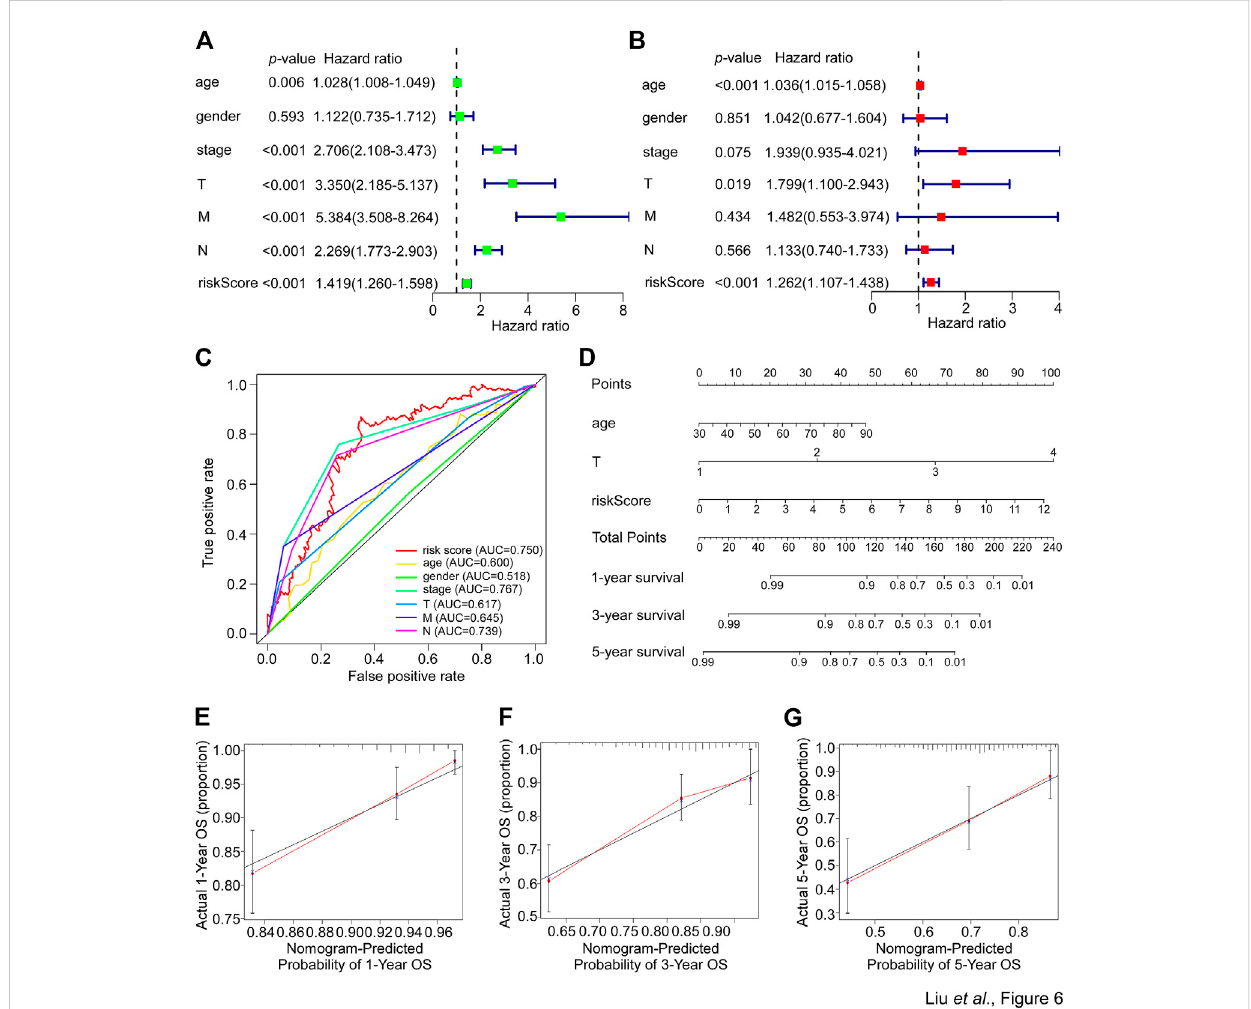
FIGURE 6 Nomogram developmentin the TCGA cohort. (A) The clinical factors and risk score calculated by the risk score formula of patients from theTCGA- CRC cohort were used for univariate cox regression analyses with overall survival. The hazard ratio values were used to generate a forest plot and the p values were shown. (B) The clinical factors and risk score calculated by the risk score formula of patients from the TCGA-CRC cohort were used for multivariate cox regression analyses with overall survival. The hazard ratio values were used to generate a forest plot and the p values were shown. (C) The prognostic performance of the clinical factors including age, gender, stage, T, N and M and risk score calculated by the risk score formula of patients from the TCGA-CRC cohort were veri fi ed by AUC of time-dependent ROC curve. (D) The clinical factors and risk score calculated by the risk scoreformulaofpatientsfromtheTCGA-CRCcohortwereusedtoperformnomogramanalysestopredict1-,3-,5-year overallsurvivalofCRCpatients. (E – G) The calibration curves test consistency between the actual overall survival rates and the predicted survival rates at 1 (E) , 3 (F) , and 5 (G)